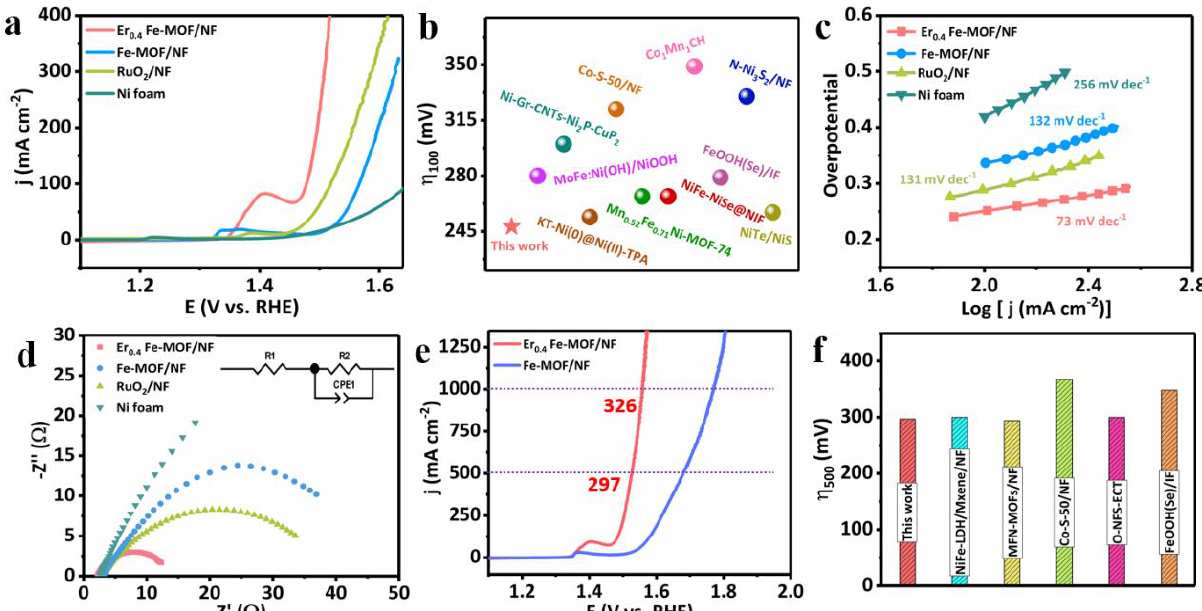
Figure 3. LSV curves of NF - based electrodes tested in 1.0 M KOH ( a ). Comparing the overpotential of Er 0.4 Fe - MOF/NF at 100 mA cm − 2 with other literatures ( b ). Tafel slopes ( c ) and EIS ( d ) of Ni foam, Fe - MOF/NF, commercial RuO 2 and Er 0.4 Fe - MOF/NF. LSV curves ( e ) and OER performance comparison histogram ( f ). Figure 4a displayed a continuous multistep chronopotentiometry curve for Er 0.4 Fe-